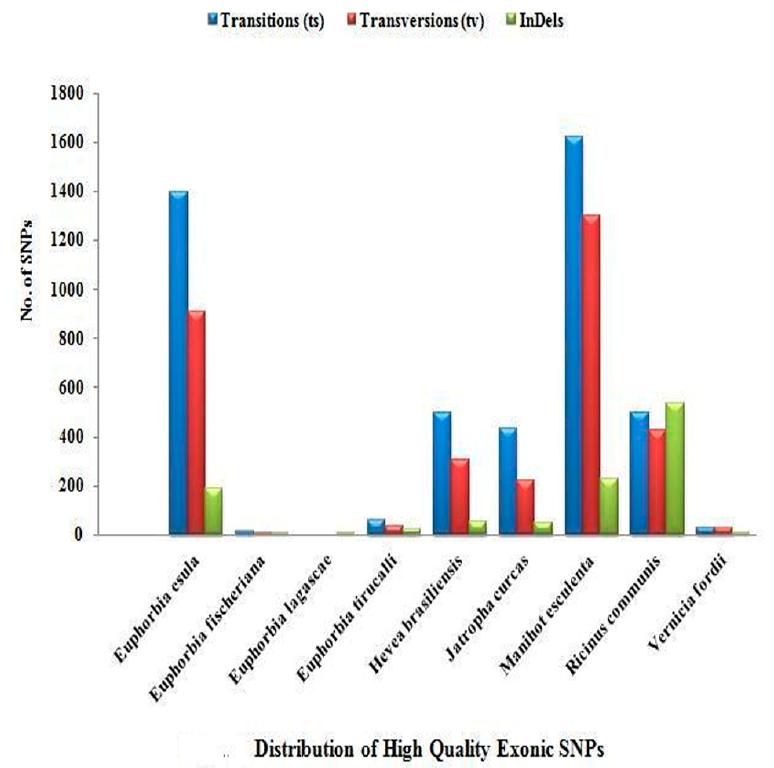
Figure 2. Distribution of high-quality exonic single-nucleotide polymorphisms (SNPs).